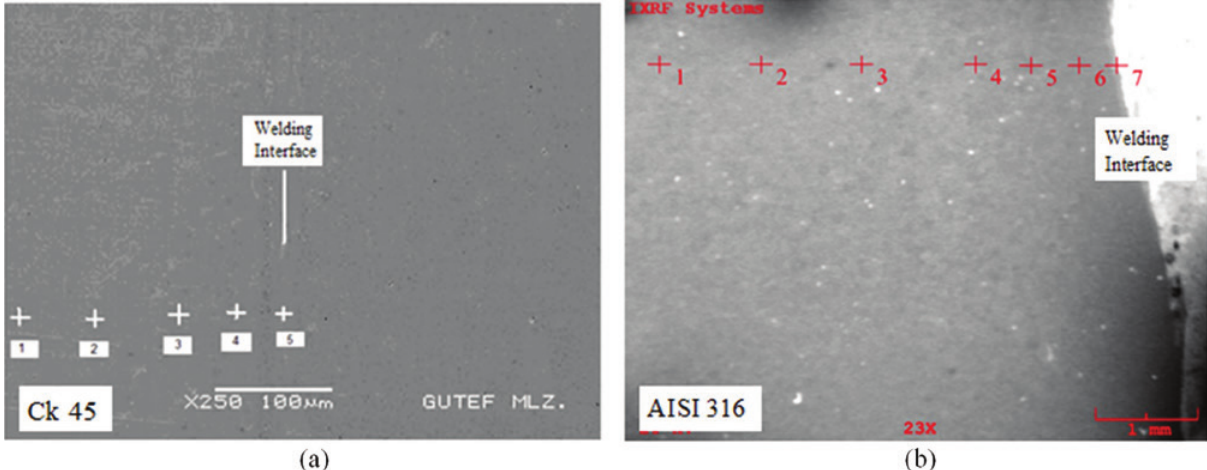
Fig. 8: EDS points of sample 13’s FESEM taken by (a) Ck 45, (b) AISI